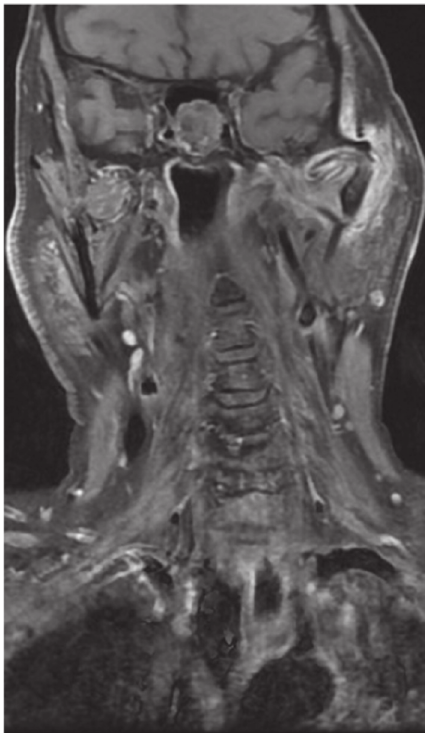
Figure 3: T1-weighted coronal section MRI showing abnormal soft tissue enhancement centred on the left